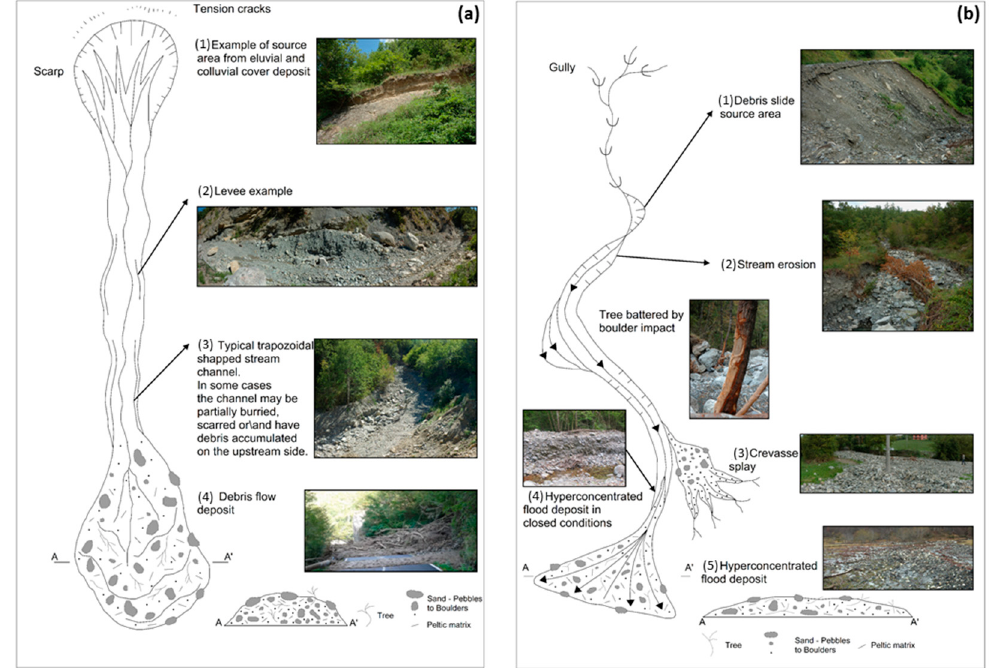
Figure 3. ( a ) Model of hillslope-debris flow derived from the geomorphological mapping where the typical landforms of source area (1), levees (2), channel (3) and deposit (4) are shown. ( b ) Field-work- based model of a hyperconcentrated flow in which the source area (1), stream erosion (2), crevasse splay (3), and deposits, both in open (4) and confined (5) condition, are shown.